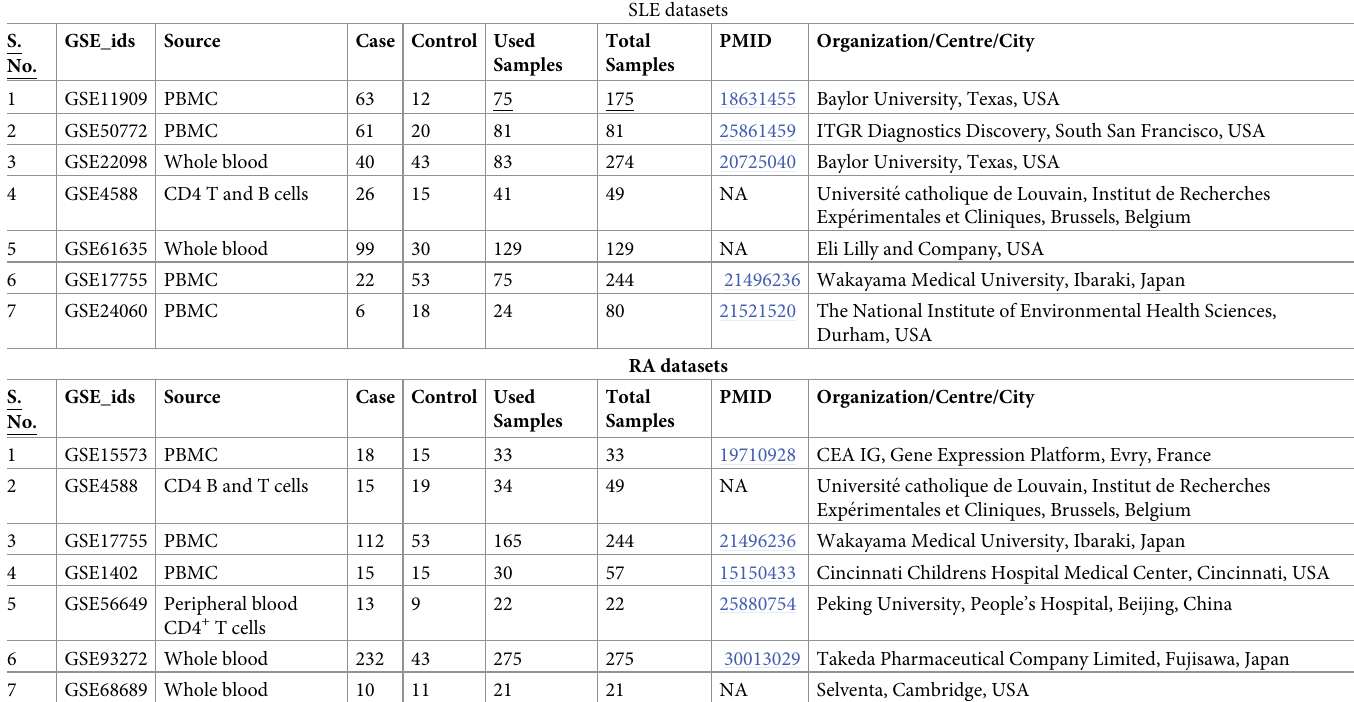
Table 1. Summary of the included RA and SLE datasets and their samples.